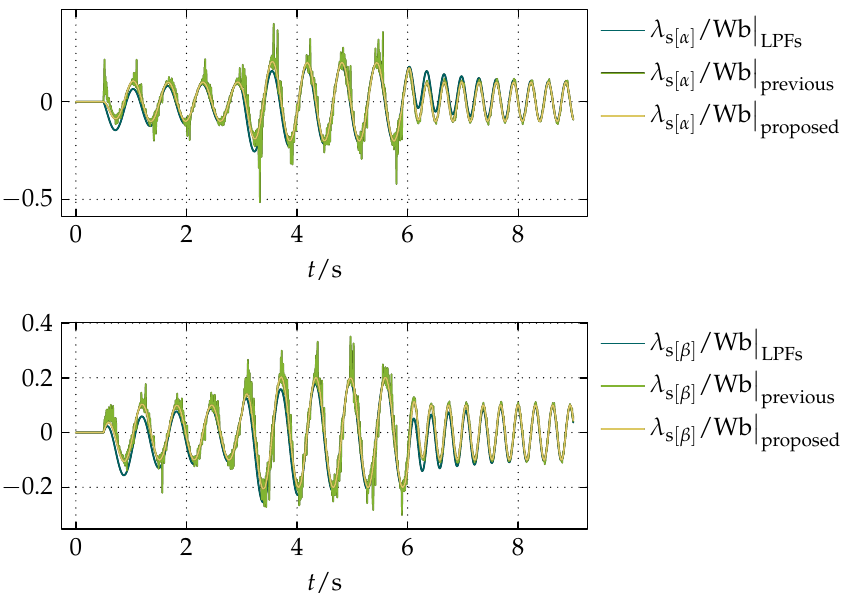
Figure 14. The resulting waveforms of λ s [ α ] and λ s [ β ] obtained by the simulation of the standard solution with LPFs presented in [5–11], the previous compensation presented in [23], and the proposed compensation, all with the noisy test signals.